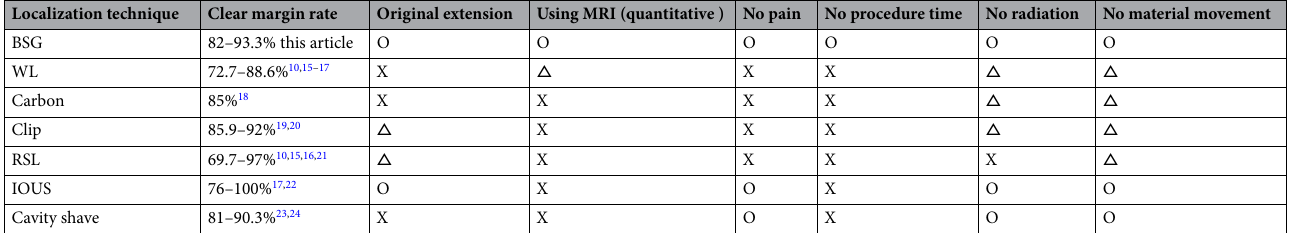
Table 4. Tumor localizations and lumpectomy techniques in breast-conserving surgery. BSG breast surgical guide, WL wire localization, carbon carbon marking, clip clip marker localization, RSL radioactive seed localization, IOUS intraoperative ultrasound-guided excision, time procedure